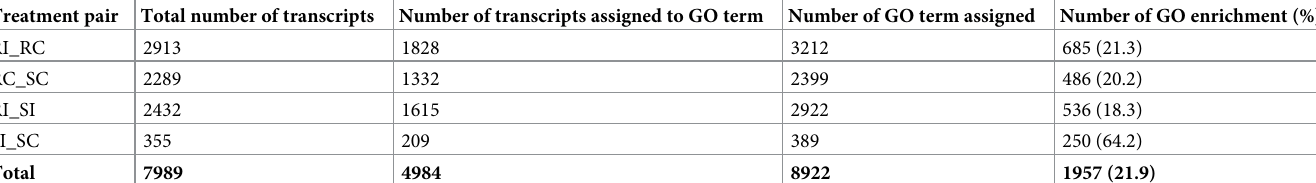
Table 4. Details of GO and GO enrichment in different resistant and susceptible